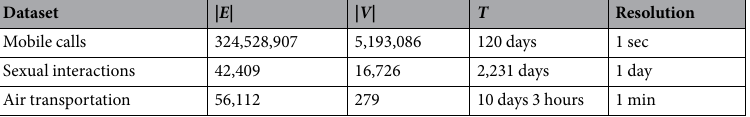
Table 1. Summary of details about the utilised